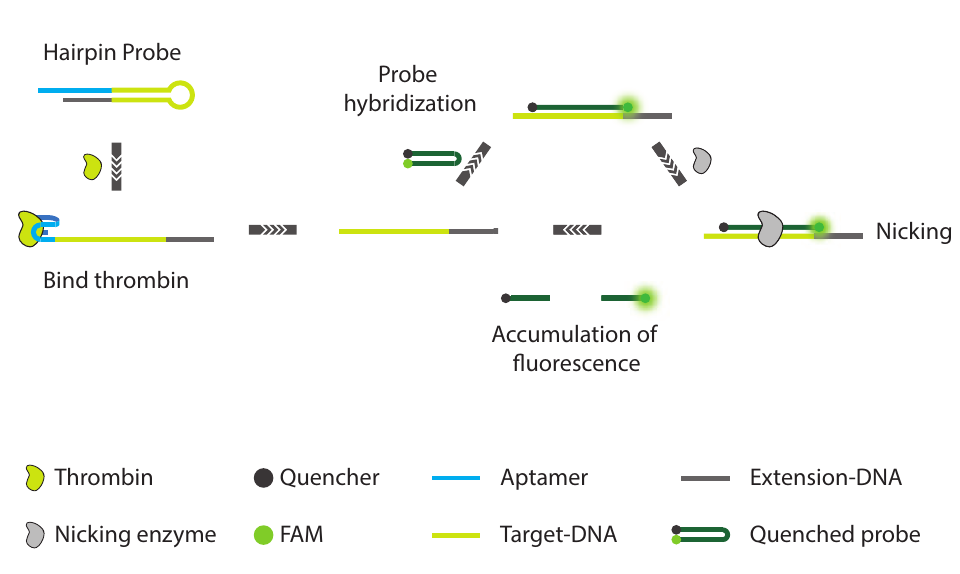
Figure 17. A schematic overview of the NEFSA assay. In the assay, an existing aptamer is extended with tailing sequences such that the free aptamer forms a hairpin